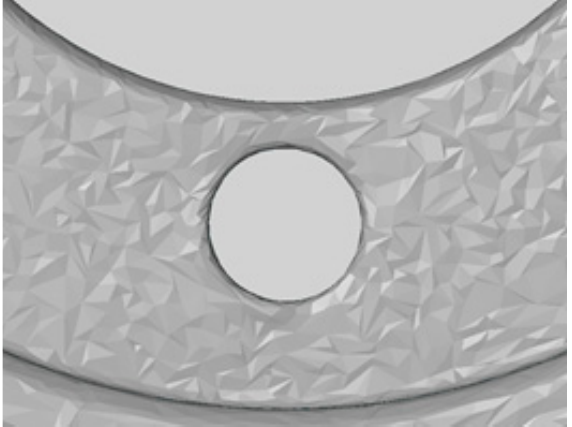
Fig. 5. A polygonal mesh (STL) created on the pipe connector.